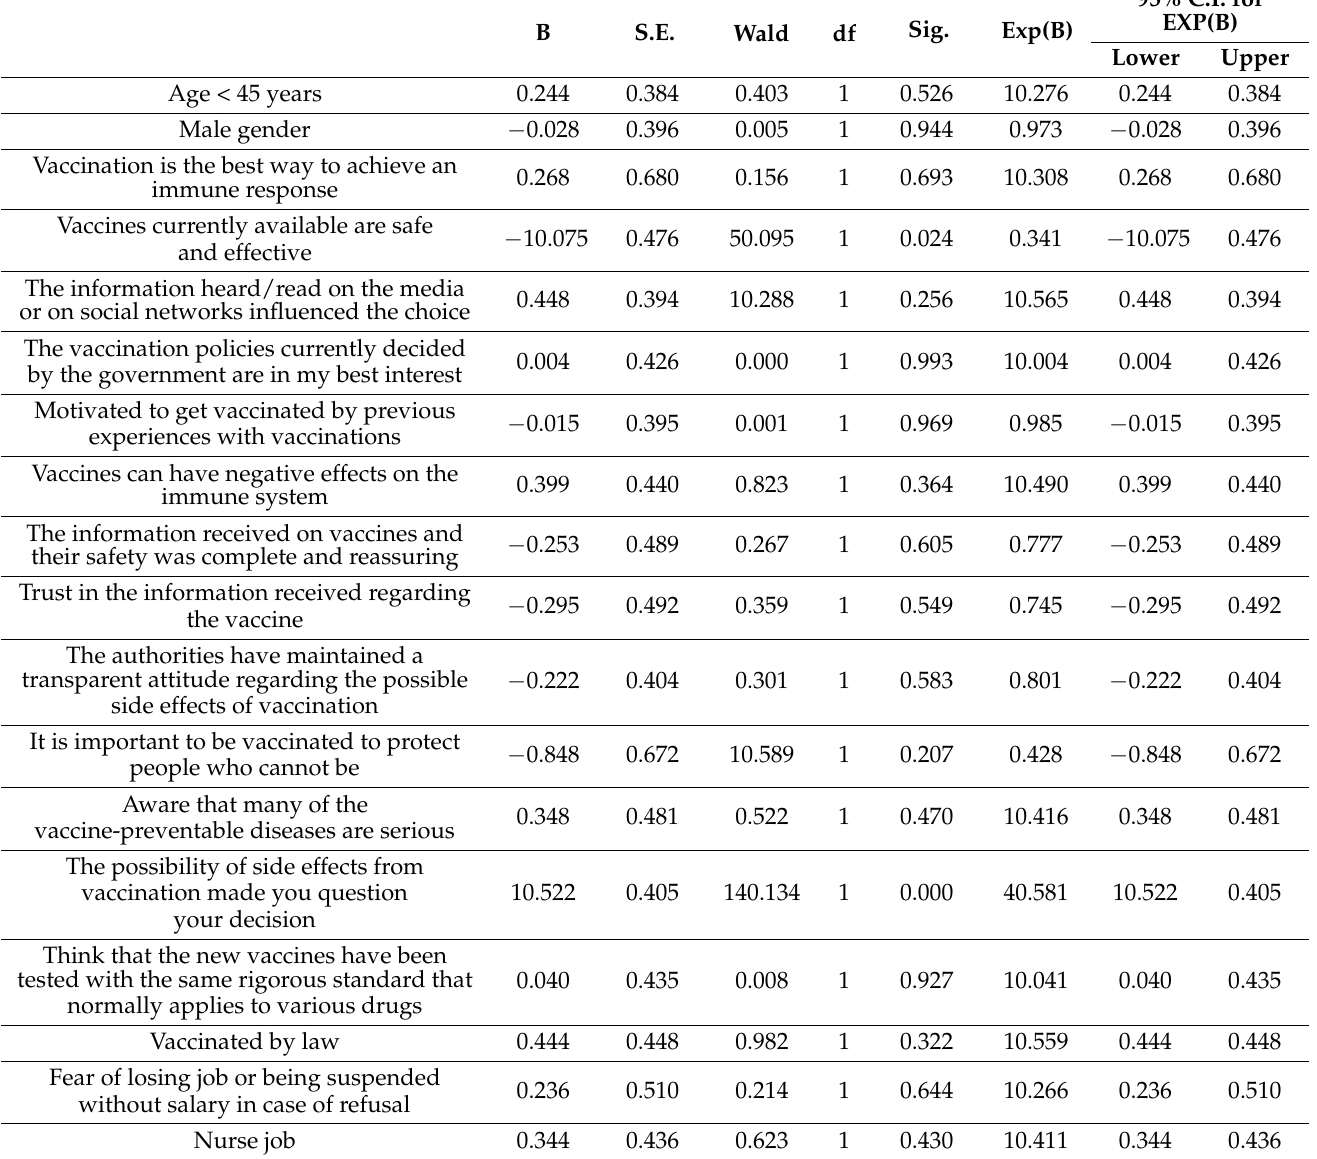
Table 3. Predictors influencing participants’ vaccine intention (multivariate